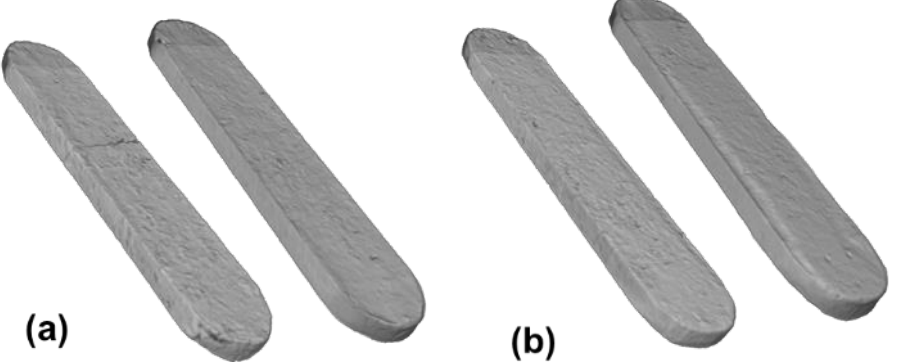
Figure 10. CT reconstruction of acid-etching morphology under different acid concentrations. ( a , b ) represents the acid concentration of 15% and 10%.